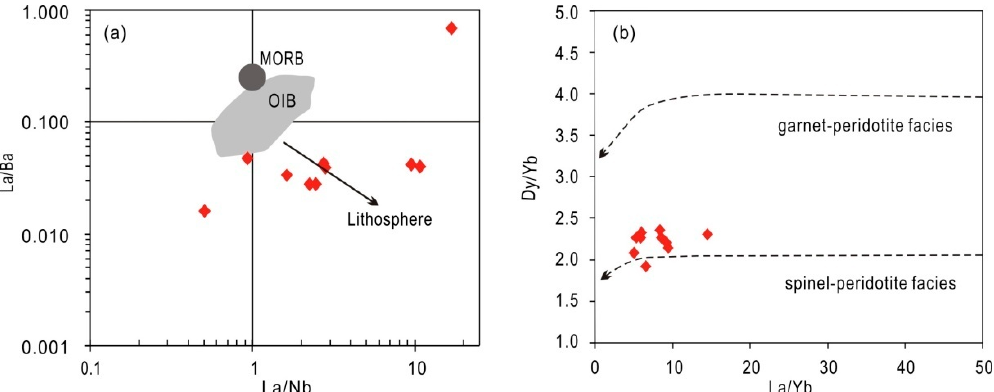
Figure 8. ( a ) La/Ba vs. La/Nb diagram and ( b ) Dy/Yb vs. La/Yb diagram showing the petrogenetic features of the Haoyaoerhudong gabbro. The fields in ( a ) are from [46]. The trends of the spinel-peridotite and garnet-peridotite facies in (b) are from [47].